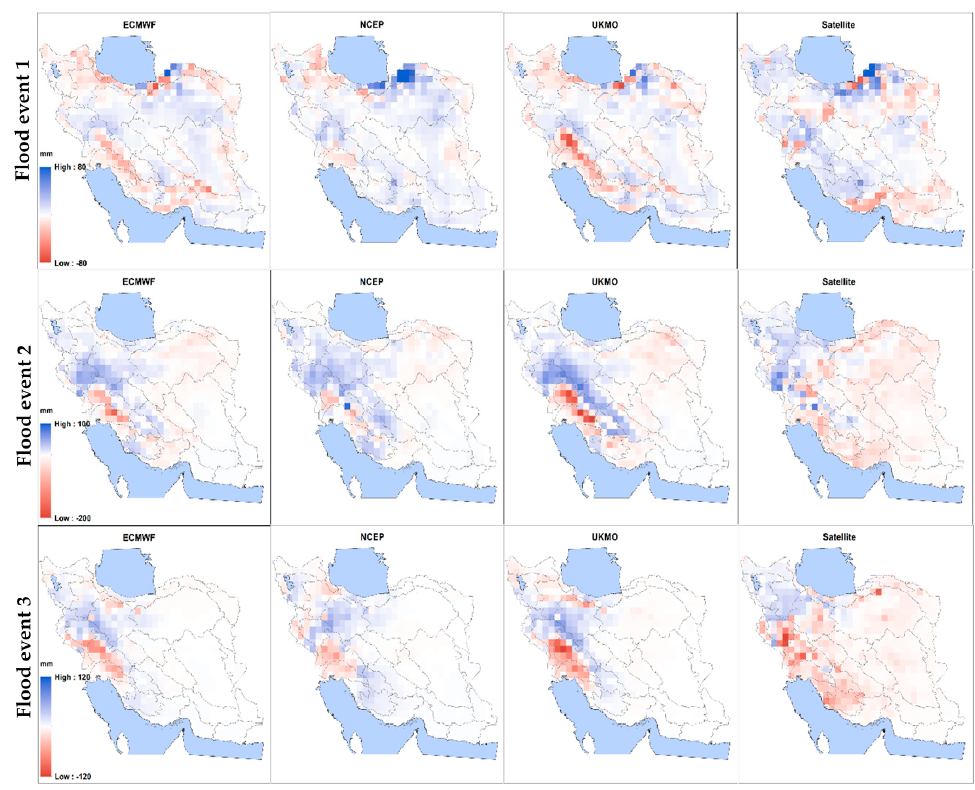
Figure 3. Differences between the accumulated precipitation in situ observations, NWP, and IMERG satellite data.